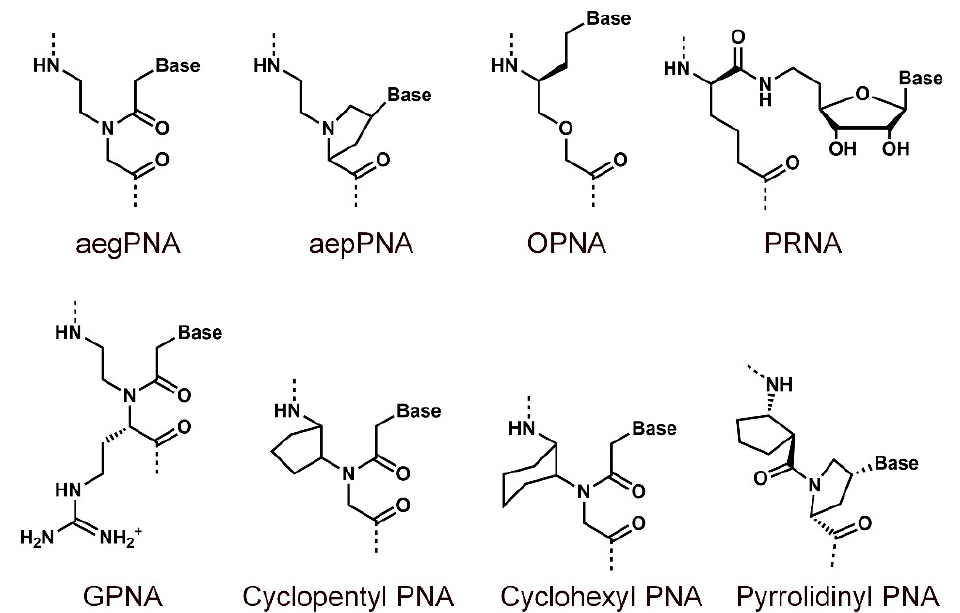
Figure 3. Structures of PNA analogs with modified backbone.